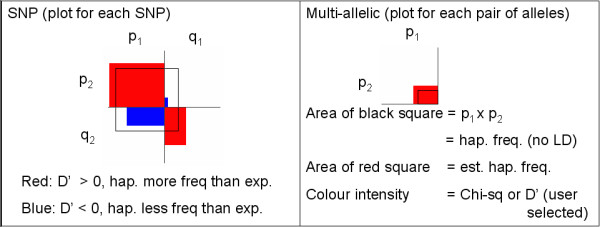
Representation of haplotype frequencies and LD in MIDAS. For SNPs the expected (under no LD) haplotype frequencies for each allele combination are plotted with an unfilled, black rectangle divided into four quadrants by two lines. The estimated haplotype frequencies are represented by solid red or blue rectangles. Where a coloured rectangle exceeds the size of the black rectangle it is coloured red, indicating an excess of that haplotype (D' ≥ 0). The opposite situation is indicated by a blue rectangle (D'<0). For multi-allelic markers the principle is the same, but a separate plot is shown for each combination of alleles, i.e. locus 1 allele i/allele not-i, locus 2 allele j/allele not-j.